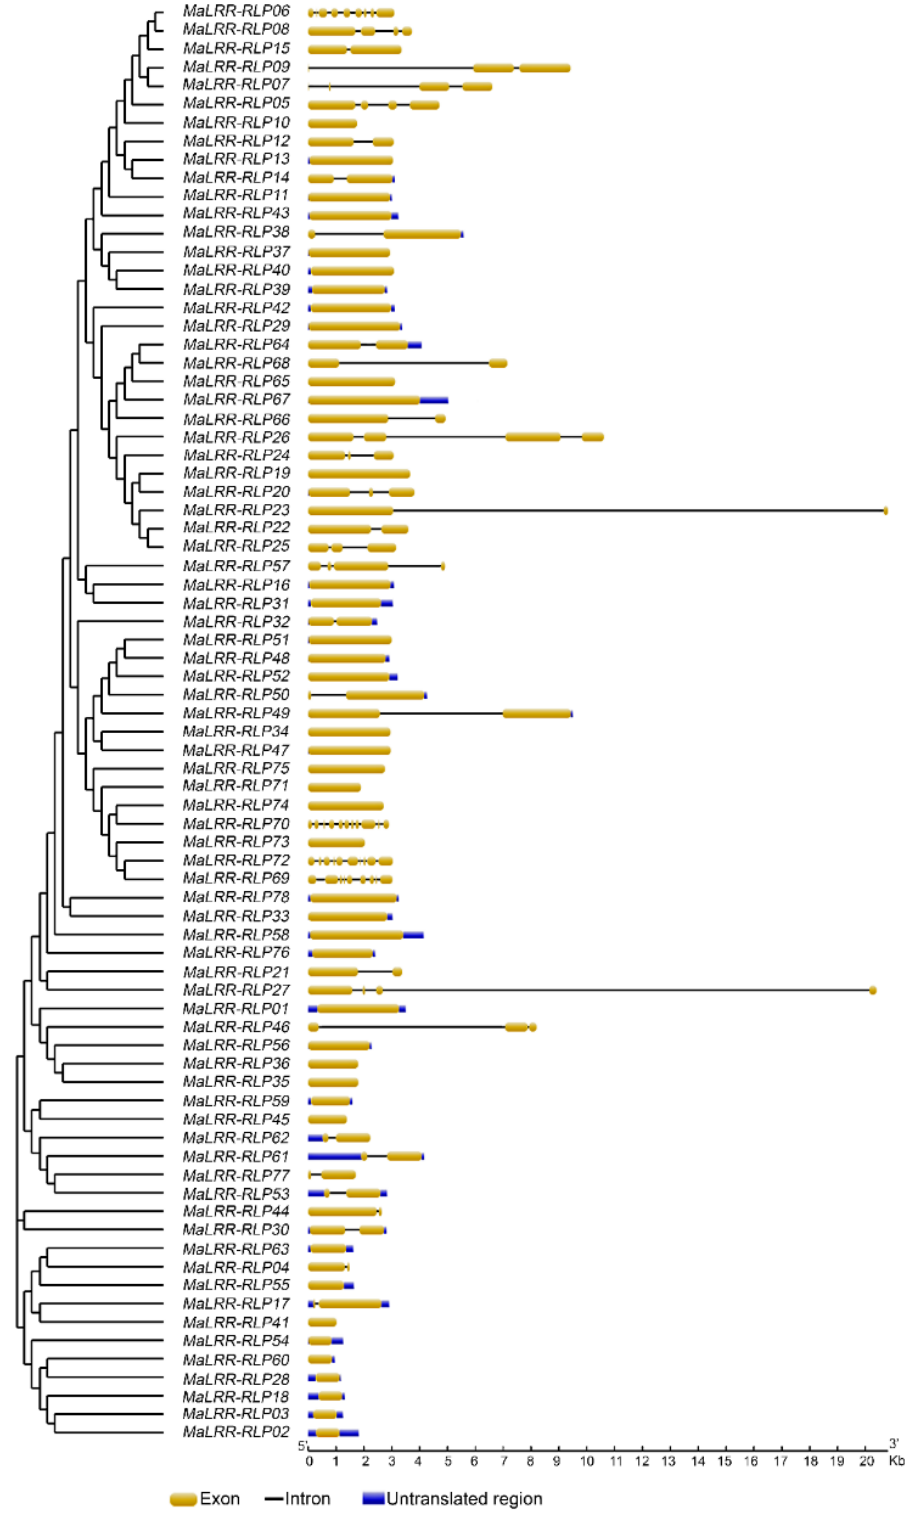
Figure 1. Gene structure of banana LRR-RLP genes. Yellow boxes indicate exons, blue boxes indicate untranslated regions and black lines represent introns.